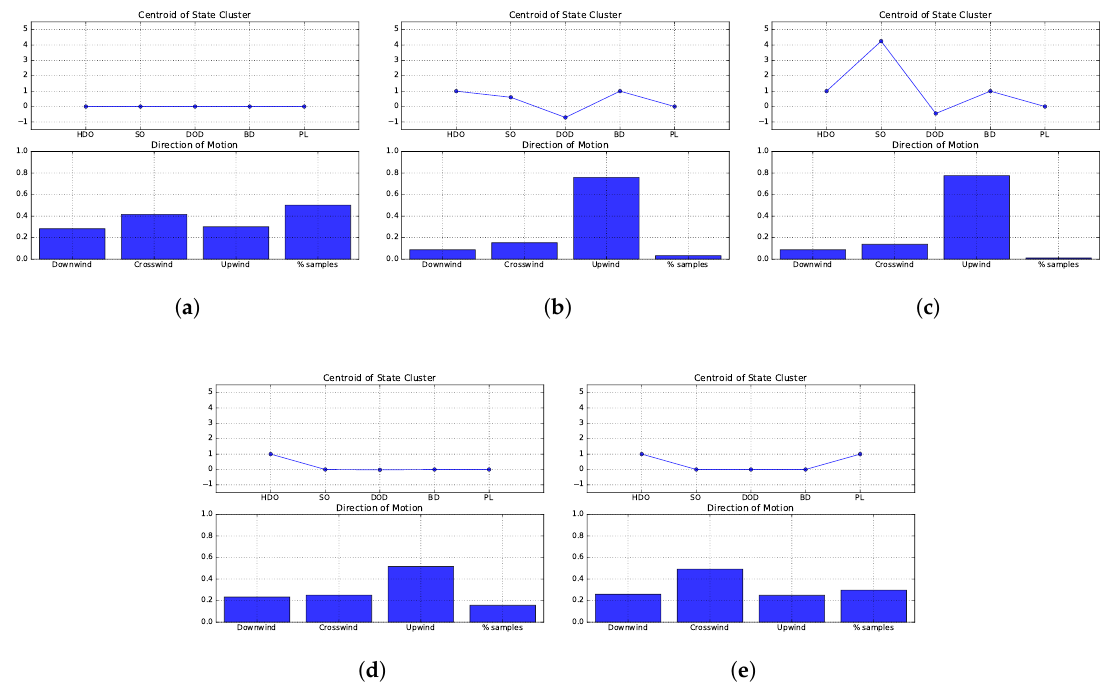
Figure 10. 5 state-action mappings for environment 1. The top of each sub-figure presents the centroid of the respective state cluster. The bottom of each sub-figure presents the histograms of relative frequency of the actions taken by all strategies in the respective state, characterized by the direction of motion. A fourth column is presented in these histograms, representing the relative amount of simulation steps that all strategies spent perceiving the respective state. ( a ) State 1: the robot has yet to detect odour; ( b ) State 2: the robot is detecting low concentrations of odour; ( c ) State 3: the robot is detecting high concentrations of odour; ( d ) State 4: the robot has recently lost the chemical plume; ( e ) State 5: the robot has lost the odour plume for an extended time